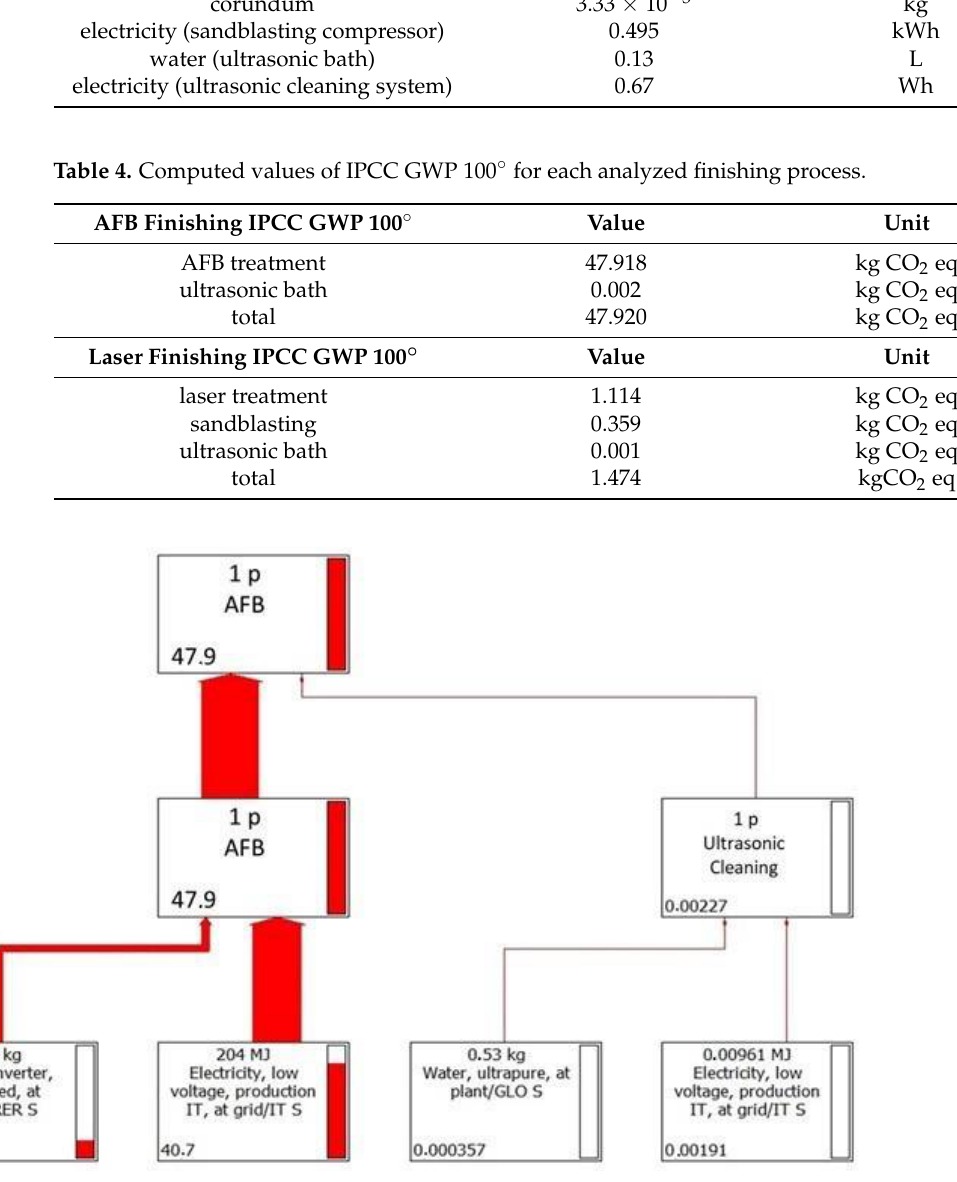
Figure 10. Life cycle of AFB